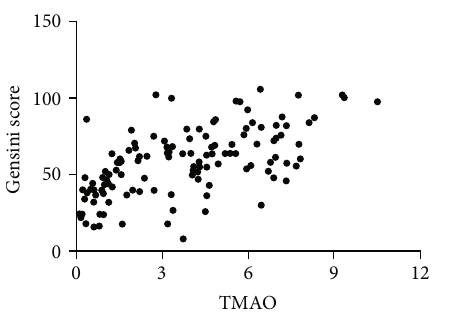
Figure 1: The relationship between TMAO and atherosclerosis.